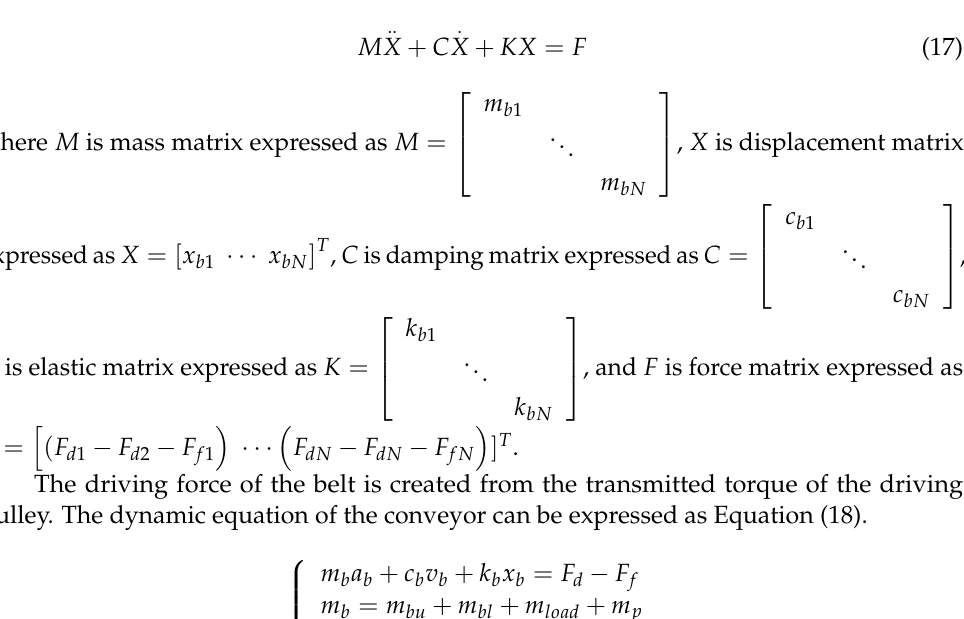
where m bi is mass of number N unit; c bi is tamping efficient of number N unit; k bi is the elastic coefficient of number N unit; 𝐹 𝑑𝑖 and 𝐹 𝑑(𝑖+1) are tensions of both ends of number elastic coefficient of number N unit; F di and F are tensions of both ends of number N d ( i + 1 ) . N unit; 𝐹 𝑓𝑖 is resistance force of number N unit; and 𝑥 𝑏𝑖 , 𝑣 𝑏𝑖 , and 𝑣̇ 𝑏𝑖 are belt displace- v bi are belt displacement, belt unit; F fi is resistance force of number N unit; and x bi , v bi , and ment, belt speed, and belt acceleration of number N unit, respectively. speed, and belt acceleration of number N unit,